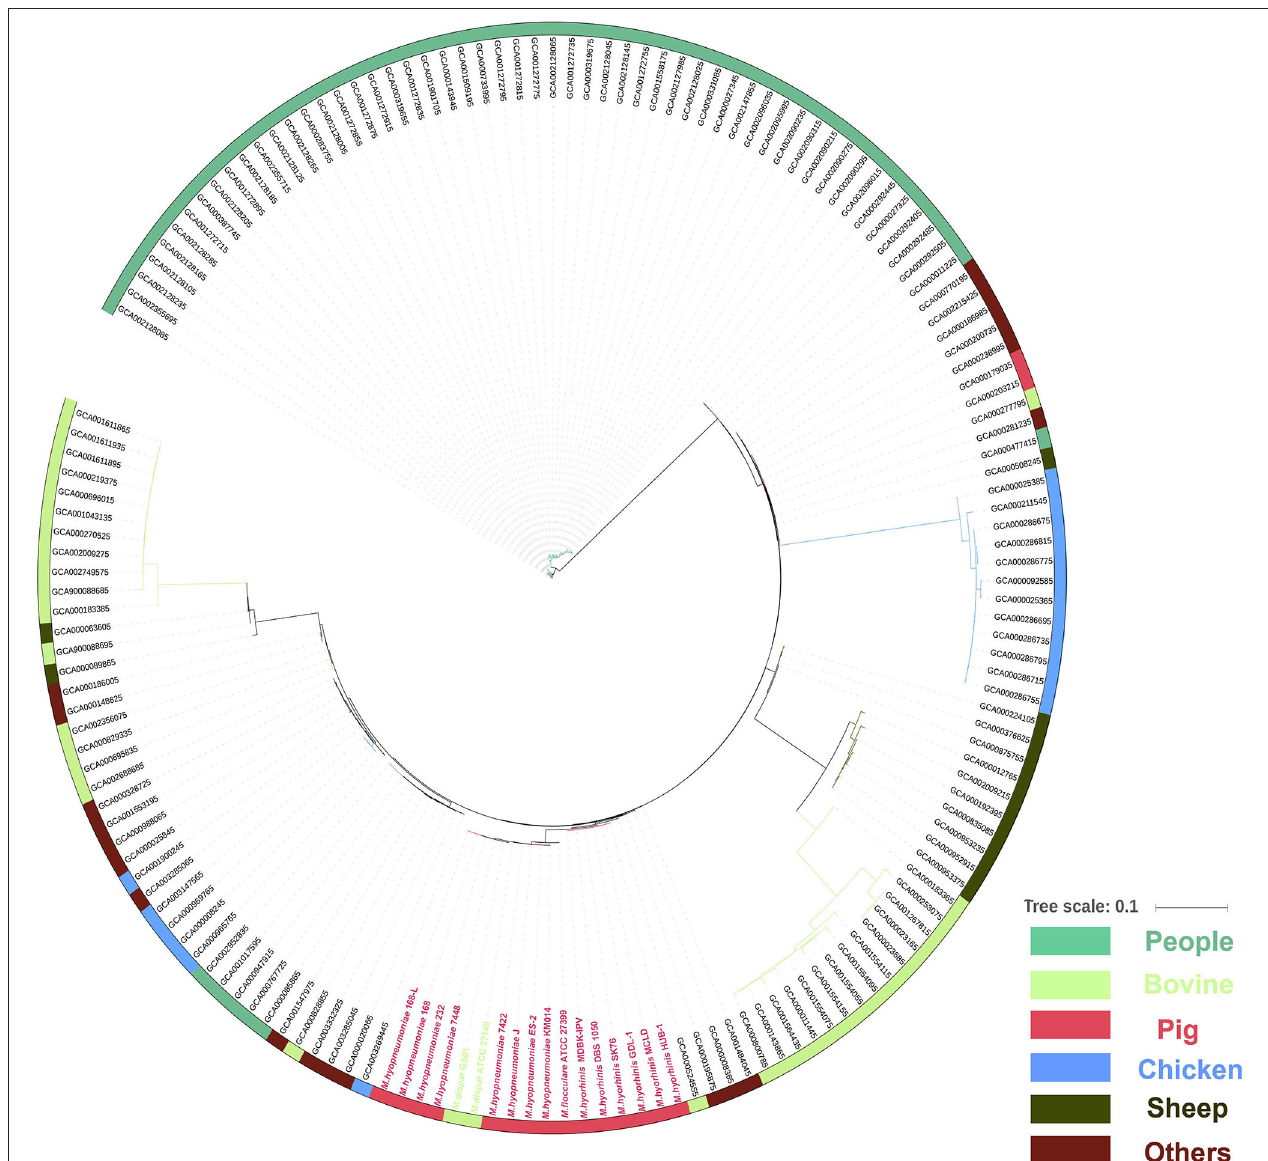
FIGURE 5 | Phylogenetic tree of the whole genome sequences of 162 mycoplasma strains isolated from human (green), bovine (light green), pig (red), chicken (blue), sheep (blackish green), and others species (purple) based on amino acid alignments of all